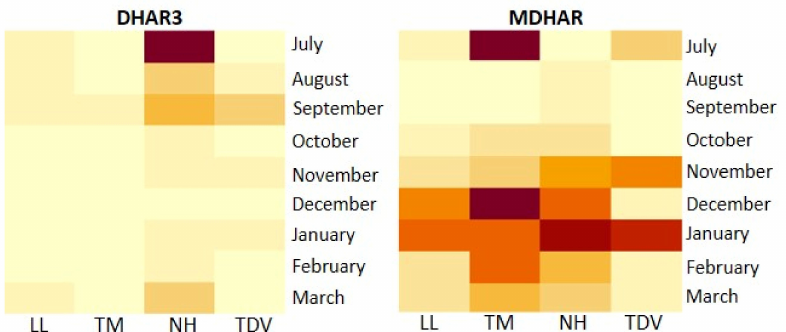
Figure 10. Heatmap of DHAR3 and MDHAR gene expression in the juice of Lanelate (LL), Tarocco Meli (TM), Newhall (NH), and Tarocco TDV (TDV) genotypes from July to March. Gene expression decreases according to the colour scale, from rust red to creamy